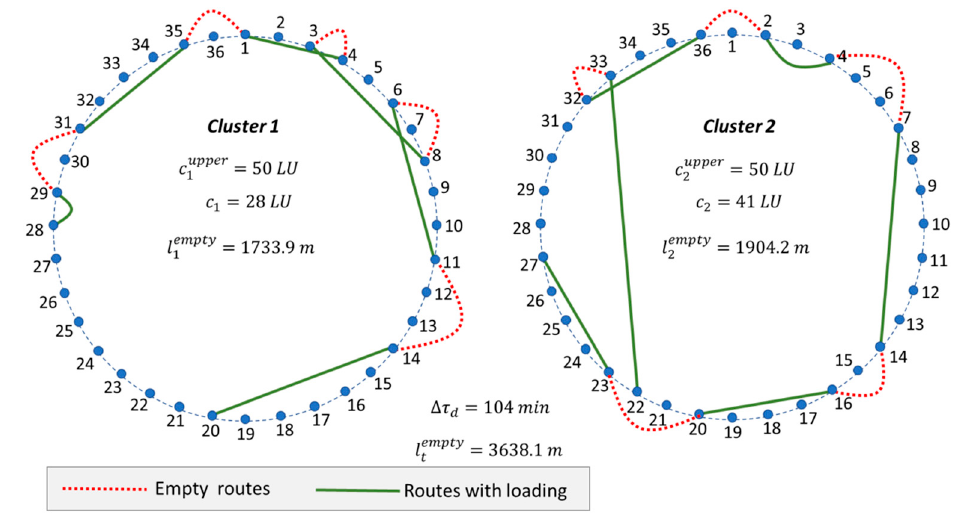
Figure 12. Clustered and sequenced supply-demands in scenario 1.